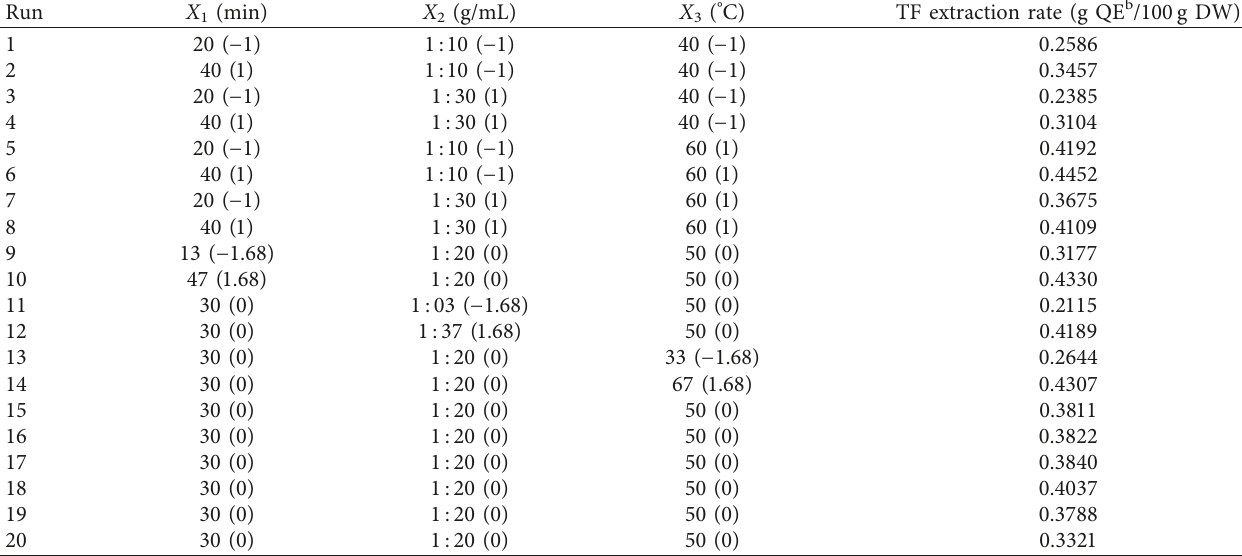
Table 2: Five-level and three-variable central composite circumscribed (CCC) design for total flavonoids (TF) extraction in D. indicum var. aromaticum and observed responses.